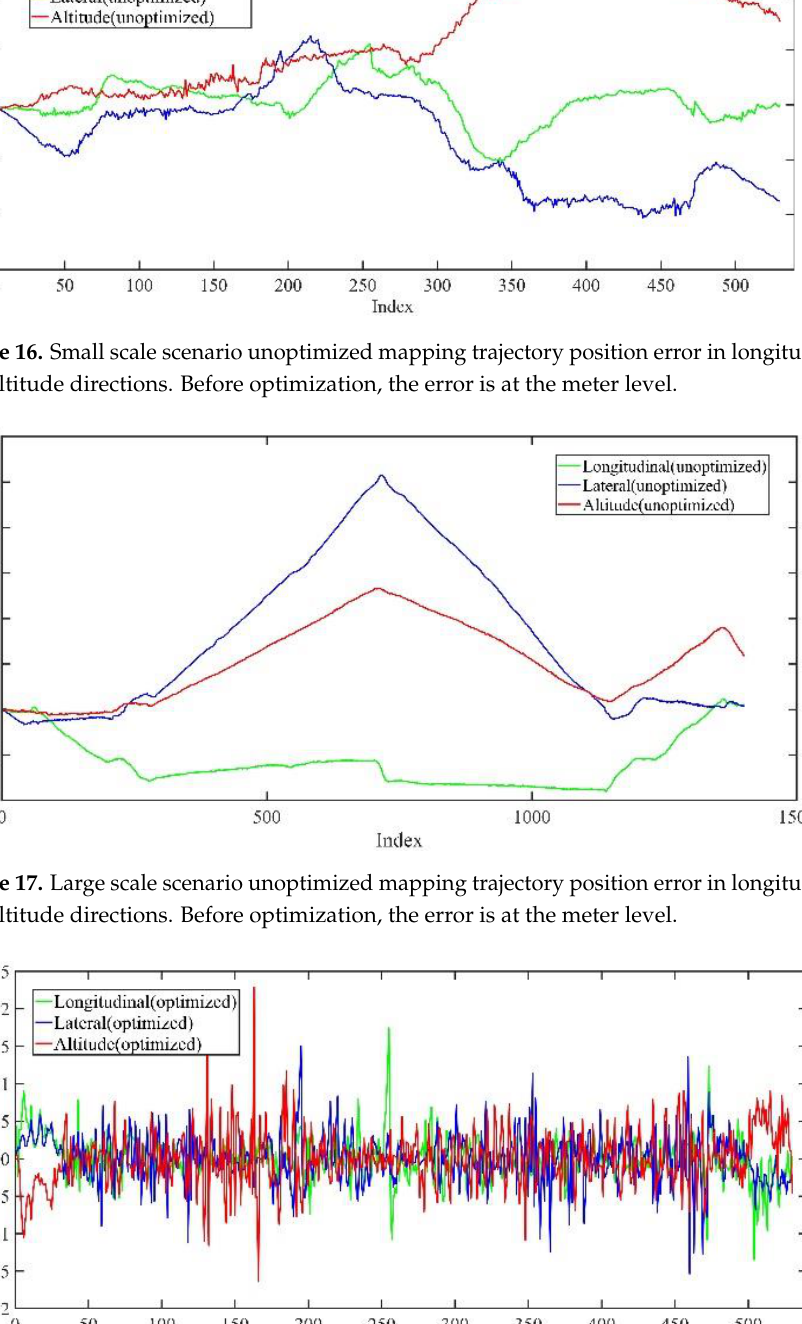
Figure 18. Small scale scenario optimized mapping trajectory position error in longitudinal, lateral, and altitude directions. After optimization, the error is at the centimeter level.